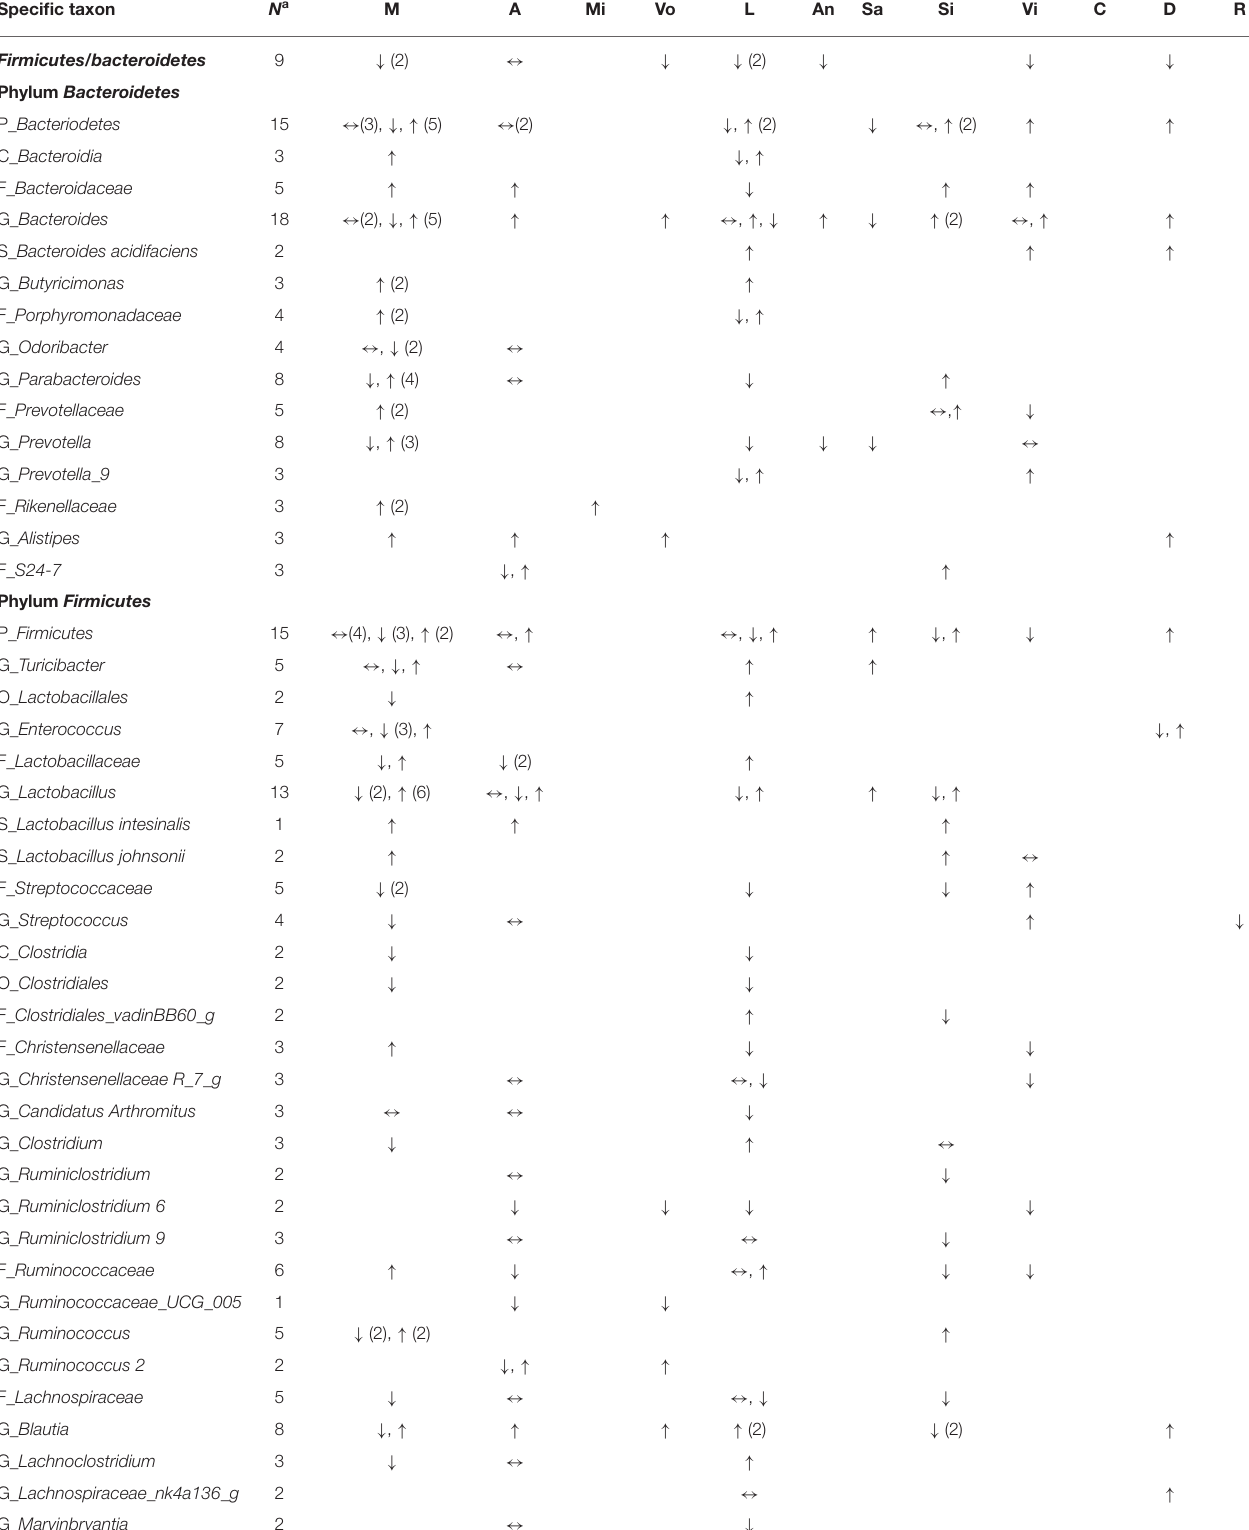
TABLE 6 | Effects of anti-hyperglycemic drugs on gut microbiota in mouse models, categorized by the treated, individual anti-hyperglycemic drug. Specific taxon